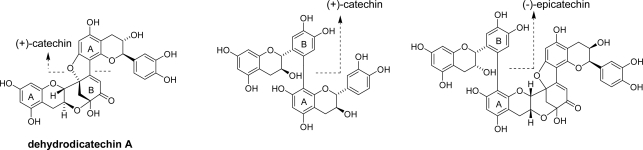
Structures of dehydrodicatechin A and related compounds [8–10].